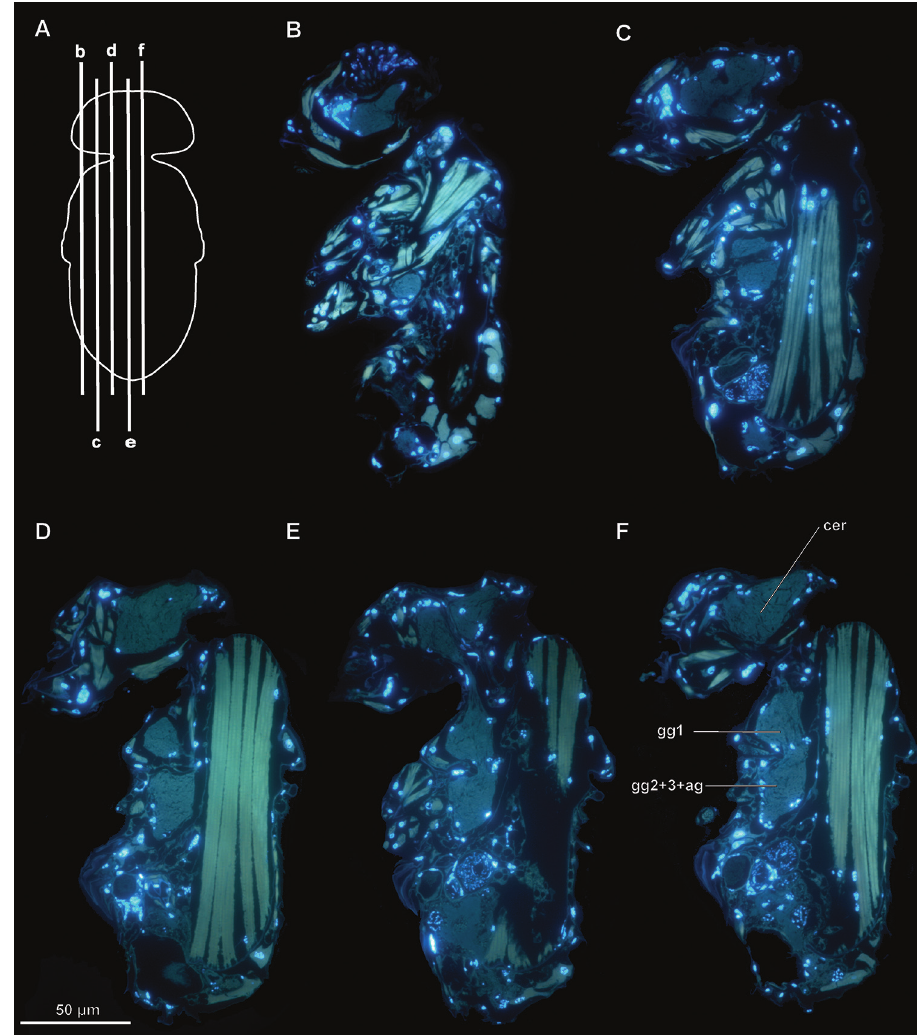
Figure 3. Internal morphology of Megaphragma caribea : A scheme of sections, dorsal view B–F sagittal sections, DAPI and autofluorescence; ag – abdominal ganglion, cer – cerebrum, gg1,2,3 – pro-, meso-, and metathoracic